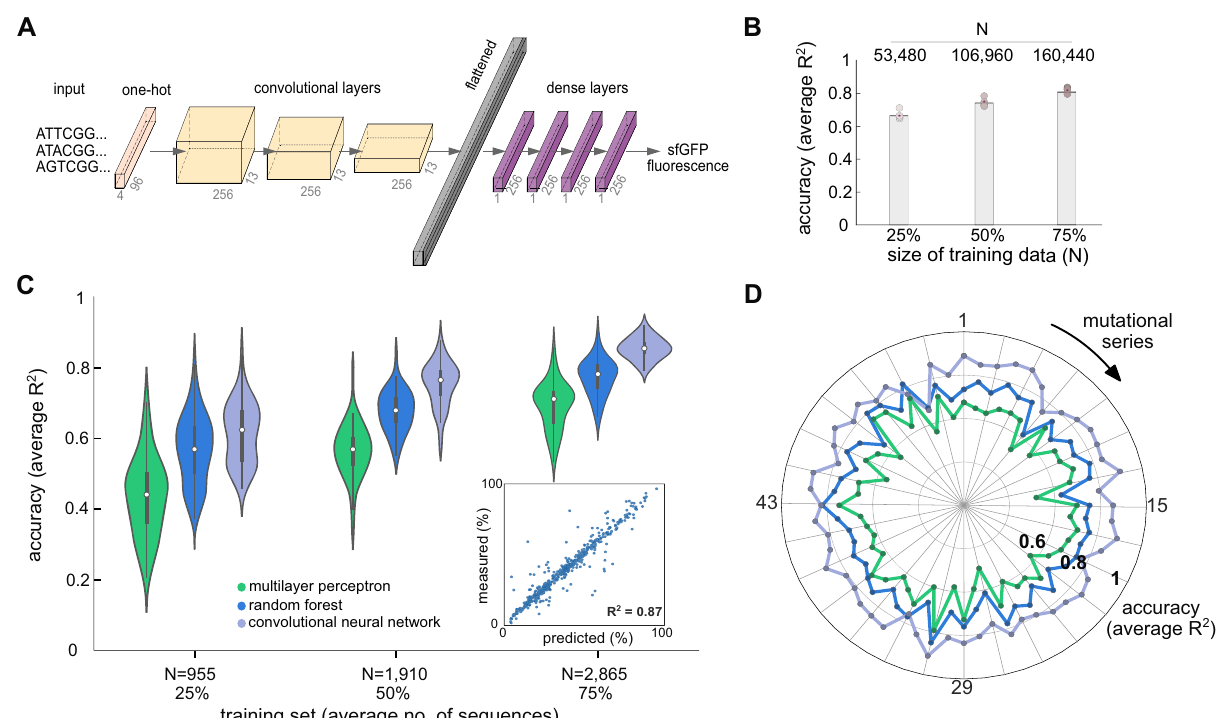
Fig. 3 | Prediction accuracy of deep neural networks. A Architecture of the convolutional neural network (CNN) employed in this paper; the output is the predicted sfGFP fl uorescencein relative units.TheCNN architecturewasdesigned with Bayesian optimization 35 to fi nd a single architecture for all mutational series; our strategy for hyperparameter optimization can be found in the Methods, Sup- plementary Fig. S3, and Supplementary Tables S4 – S5. B Accuracy of the CNN in panel A trained on all mutational series. R 2 values were computed on held-out sequences (10% of total) and averaged across 5 training repeats; bars denote the mean R 2 . C Predictionaccuracyof CNNsagainstrandomforest(RF)andmultilayer perceptrons(MLPs)onall56mutationalseriesusingbinaryone-hotencoding.The CNNs yield more accurate predictions with the same training data. Violin plots show the distribution of 56 R 2 values for each model averaged across 5 training